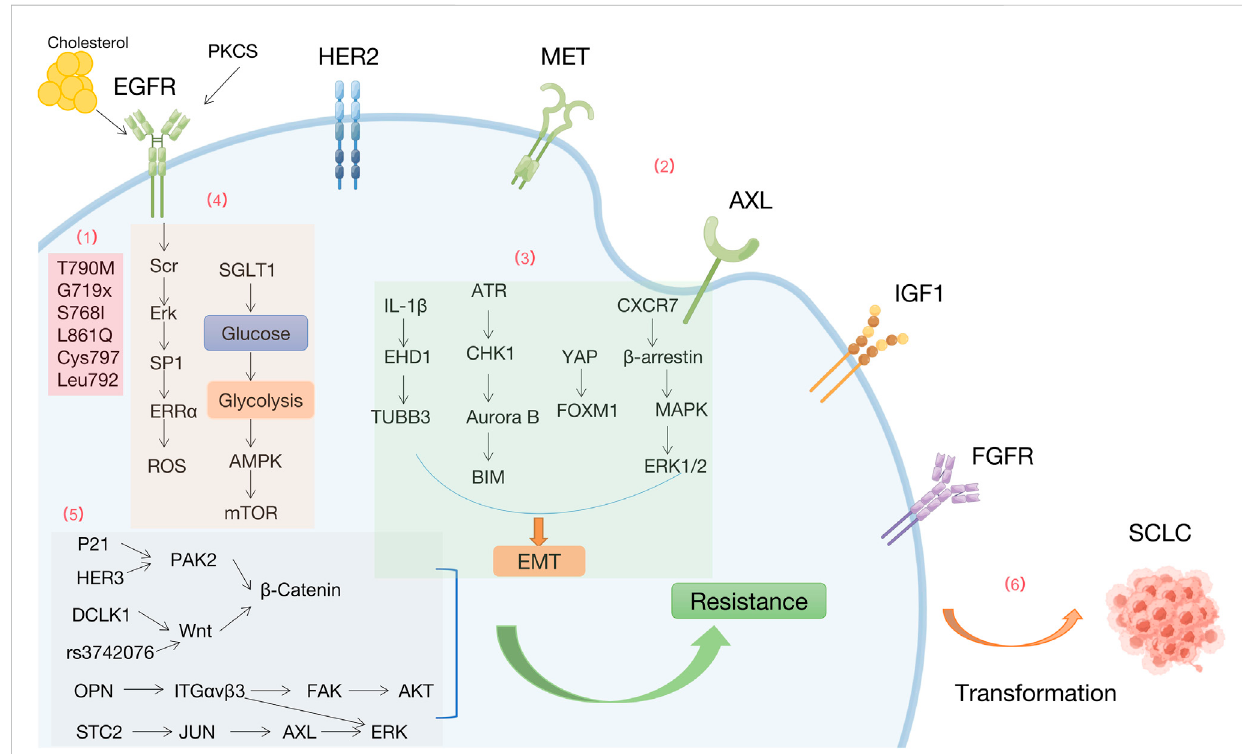
FIGURE 1 Mechanisms of resistance to EGFR-TKIs by Figdraw. (1) EGFR-dependent mutations (2) Bypass activation (3) Epithelial-mesenchymal transition (4) Metabolism. (5) Downstream signals (6) Histology and phenotypic